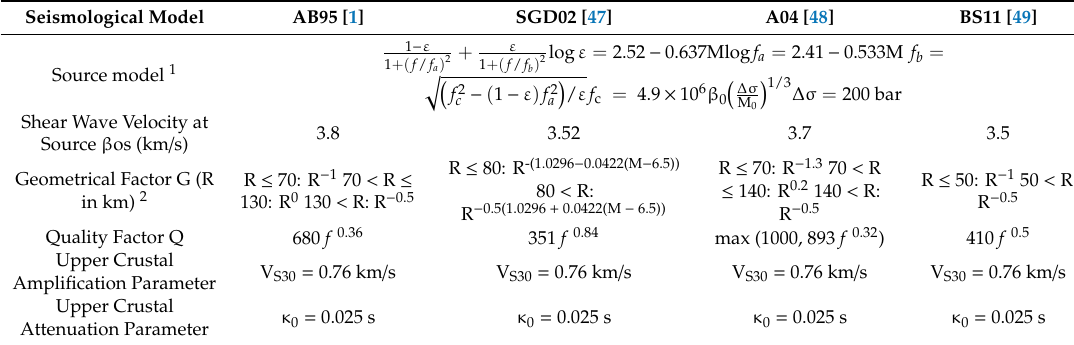
Table 2. Summary of the selected NGA-East seismological